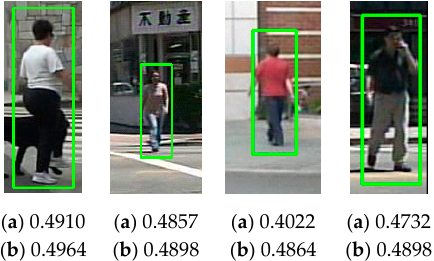
Figure 12. Scores for true positive samples (in green boxes) of the Caltech ( a ) scores by the Global network, ( b ) scores by the two-stream UDN.